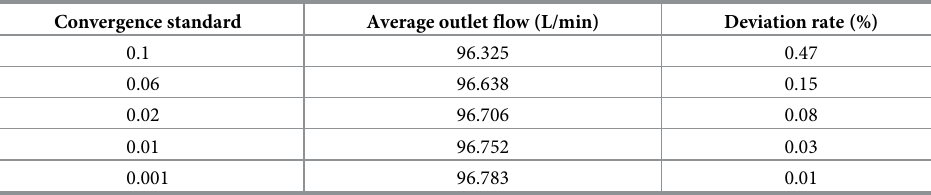
Table 6. Simulation results corresponding to different convergence